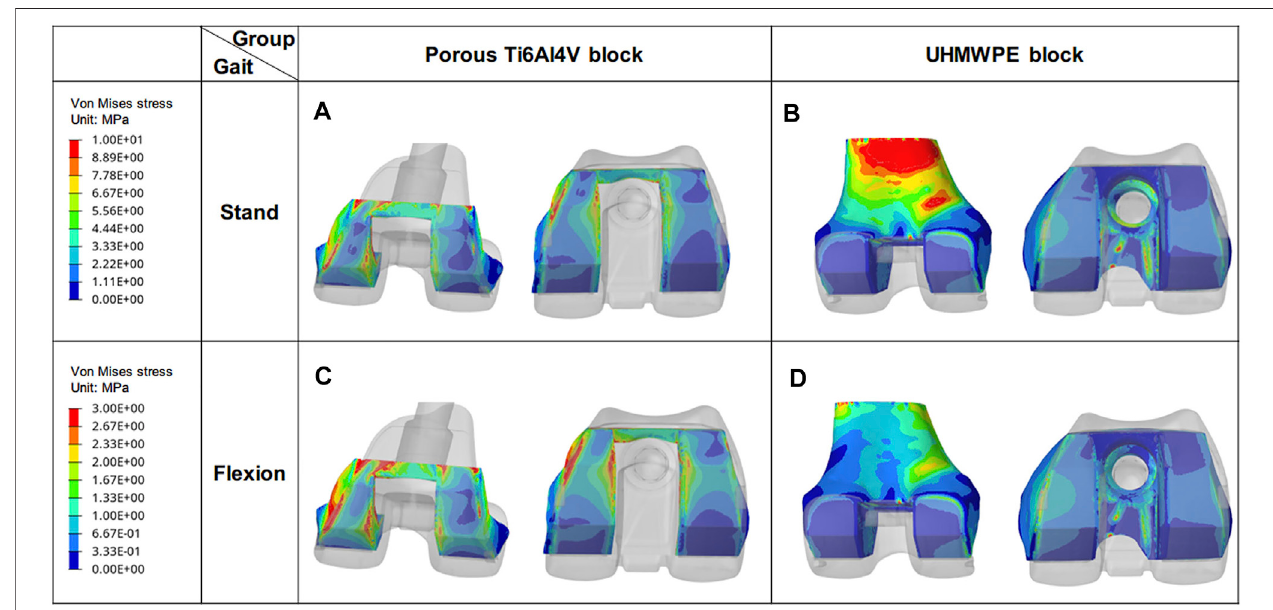
FIGURE5| VonMisesstressdistributionofblocksunderdifferentconditions. (A) and (B) arethestressdistributionsofporousTi6Al4VBlockandUHMWPE Block in the standing state, respectively. (C) and (D) are their stress distribution in the fl exing state.